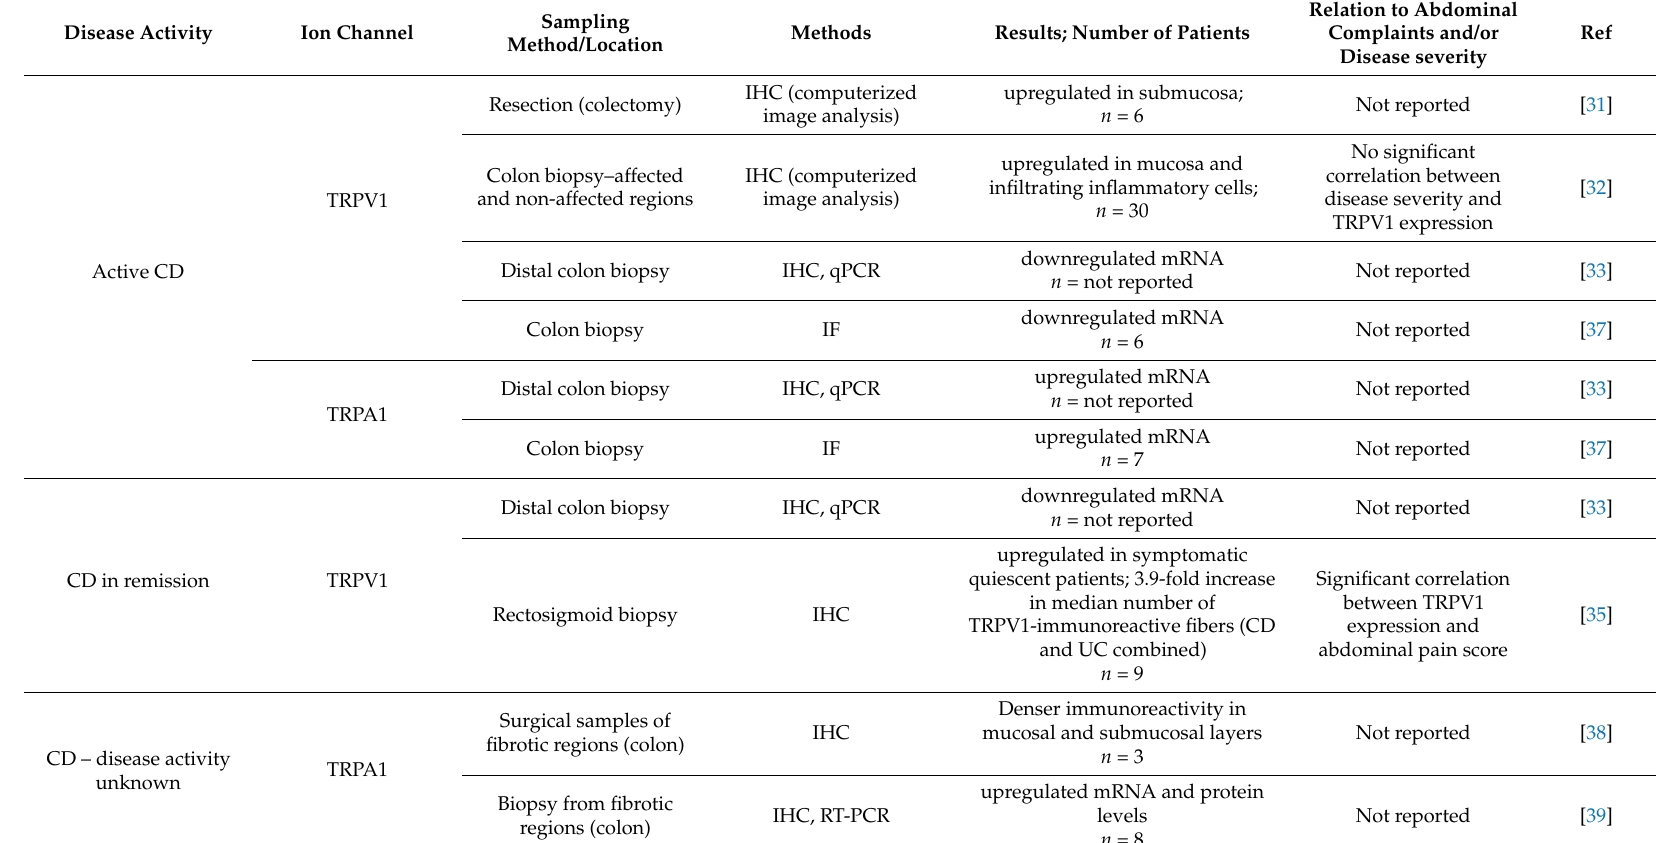
Table 1. Alterations in TRPV1 and TRPA1 transcription/expression in Crohn’s disease (CD) patients with fold-changes where available. (IHC: immunohistochemistry, IF: